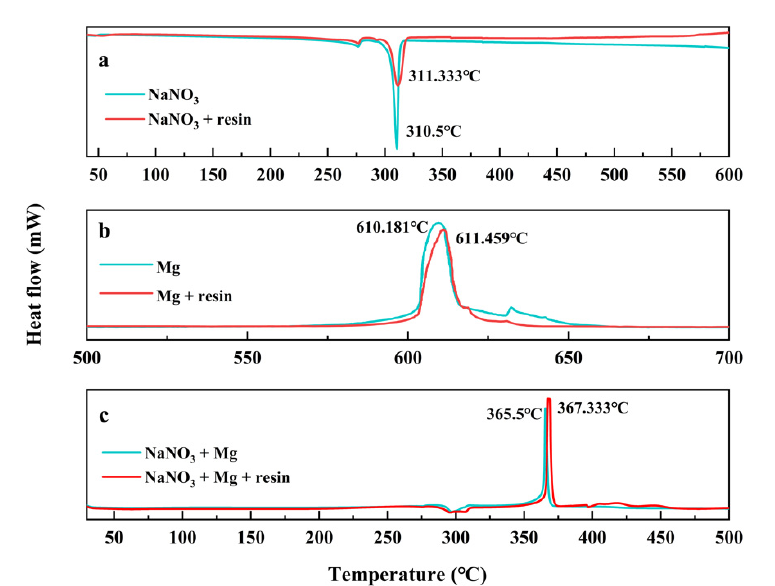
Figure 11. DSC curves of the compatibility of each component of the shell (( a ) NaNO 3 , NaNO 3 + resin; ( b ) Mg, Mg + resin; ( c ) NaNO 3 +Mg, NaNO 3 +Mg + resin).